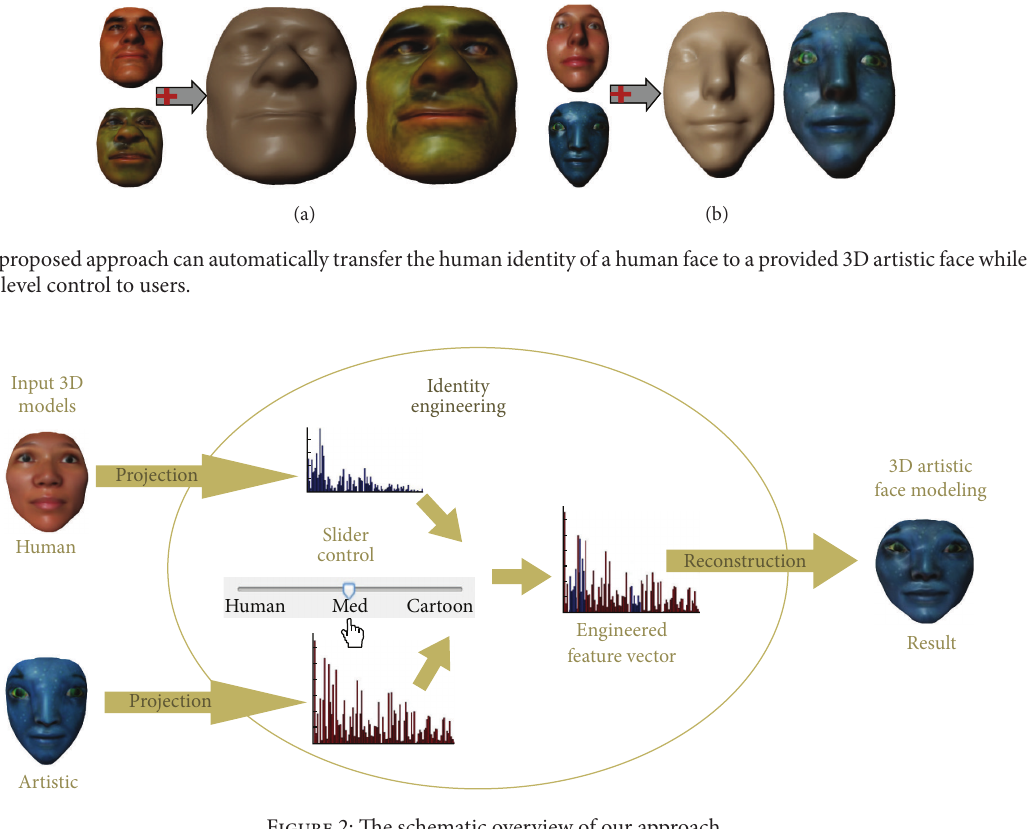
Figure 2: The schematic overview of our